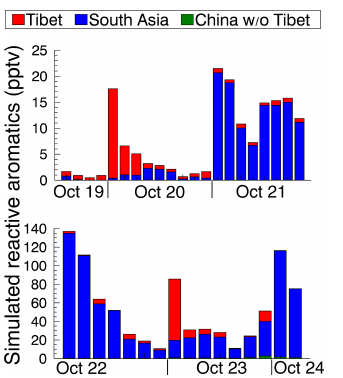
Figure 6. Reactive aromatics emitted from Tibet (red), India and nearby regions (“South Asia”, blue), and China excluding Tibet (“China w/o Tibet”, green) corresponding to the in situ observations in the REAM simulation with top-down emissions. Contributions from the other regions are negligible.